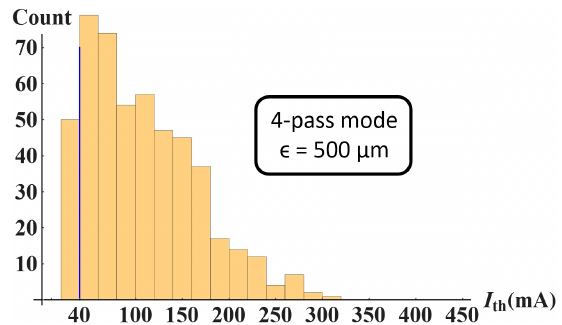
FIG. 6. 500 BBU simulation results of I with cavity shape errors within ϵ ¼ 500 μ m.